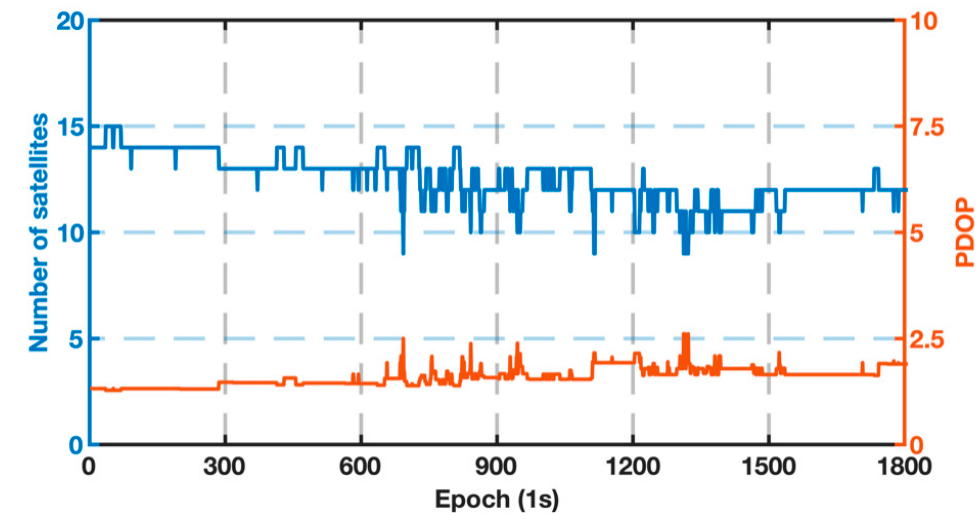
Figure 3. Number of visible BDS-3/GPS satellites and PDOPs in Experiment A.